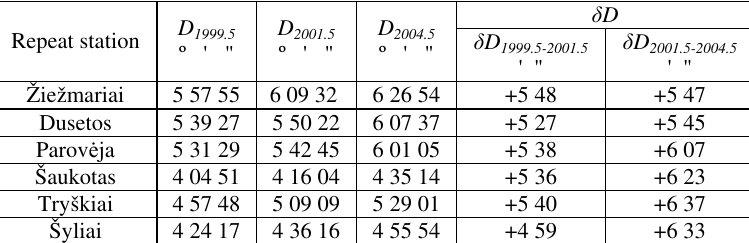
Table 1. Mean annual values and changes of geomagnetic declination